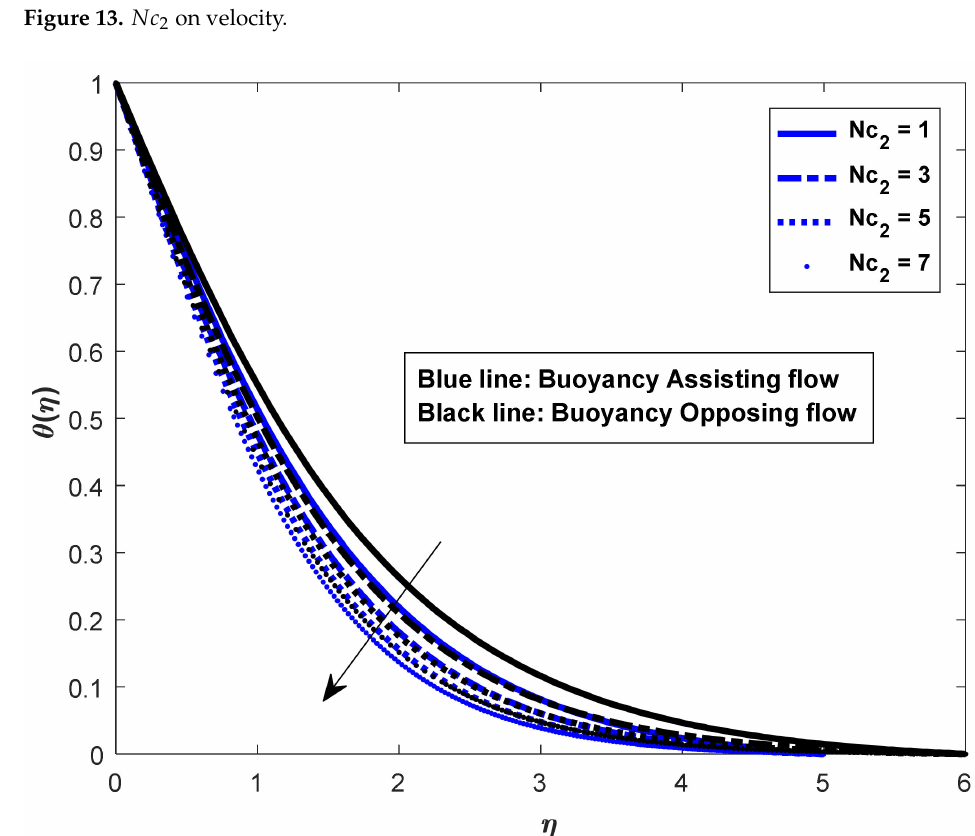
Figure 14. Nc 2 on